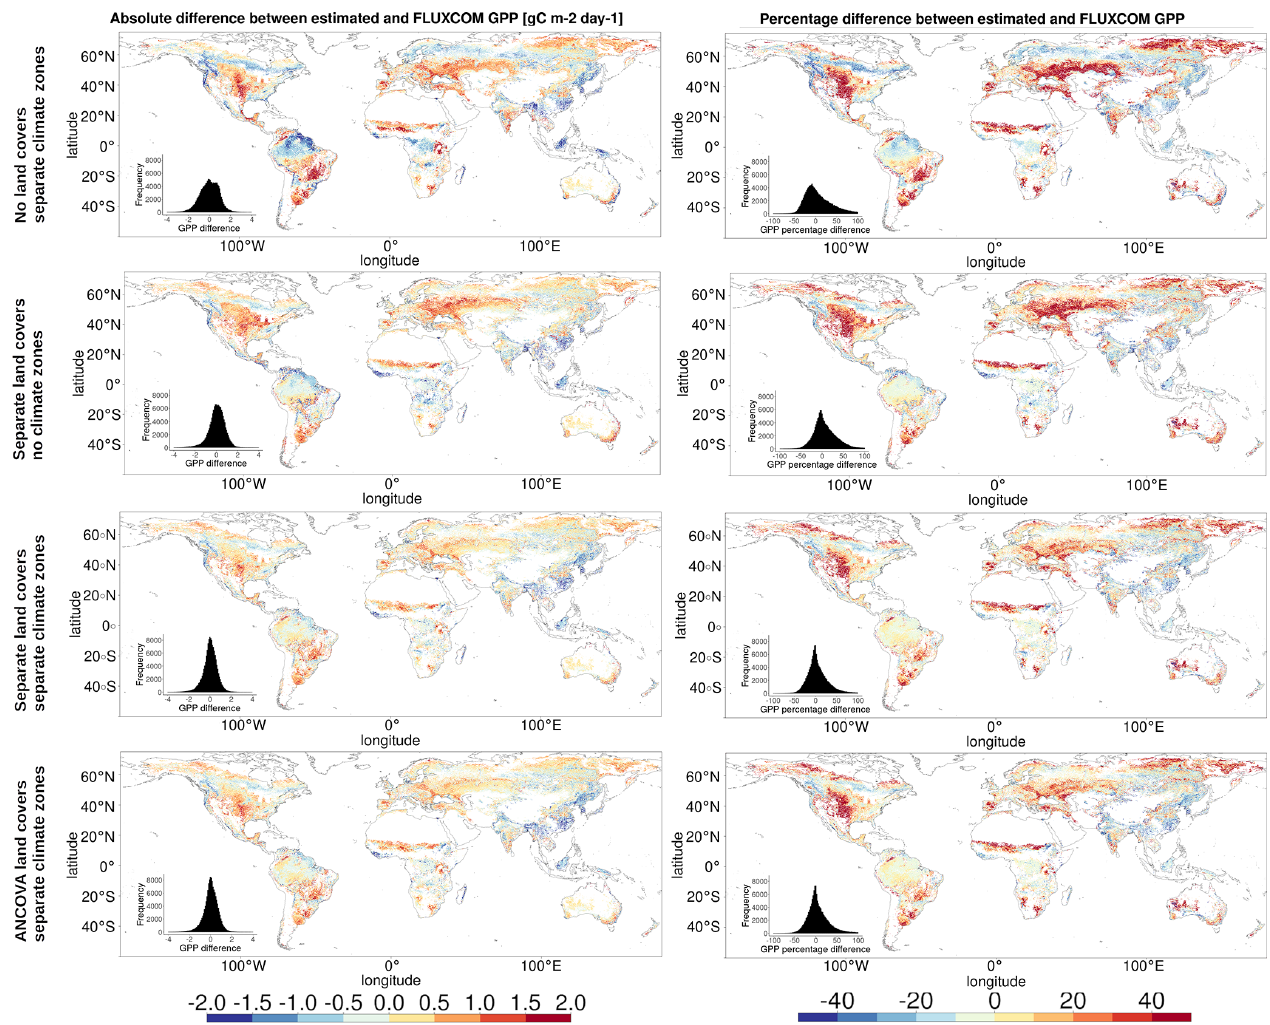
Figure 7. The absolute (left) and percentage (right) difference between the mean annual estimated primary production, GPP Est , and the mean annual FLUXCOM GPP. GPP Est is estimated by projecting the downscaled SIF at each pixel using SIF DS –GPP FX relationships derived within the following: top, each climate zone; upper middle, each vegetation cover; lower middle, each vegetation cover within each climate zone; bottom, different climate–vegetation groupings suggested by the analysis of